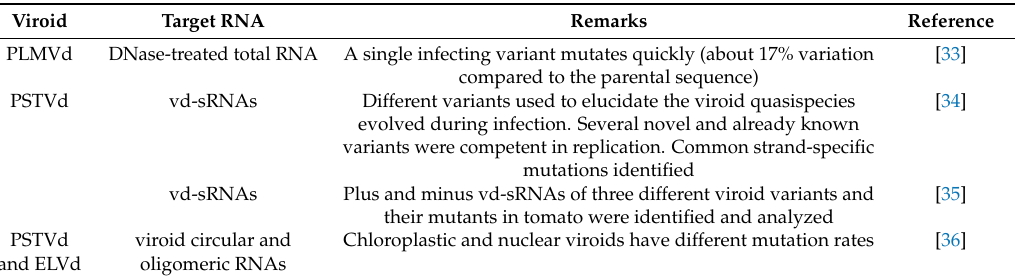
Table 3. Viroid mutants and quasi-species identified by NGS.